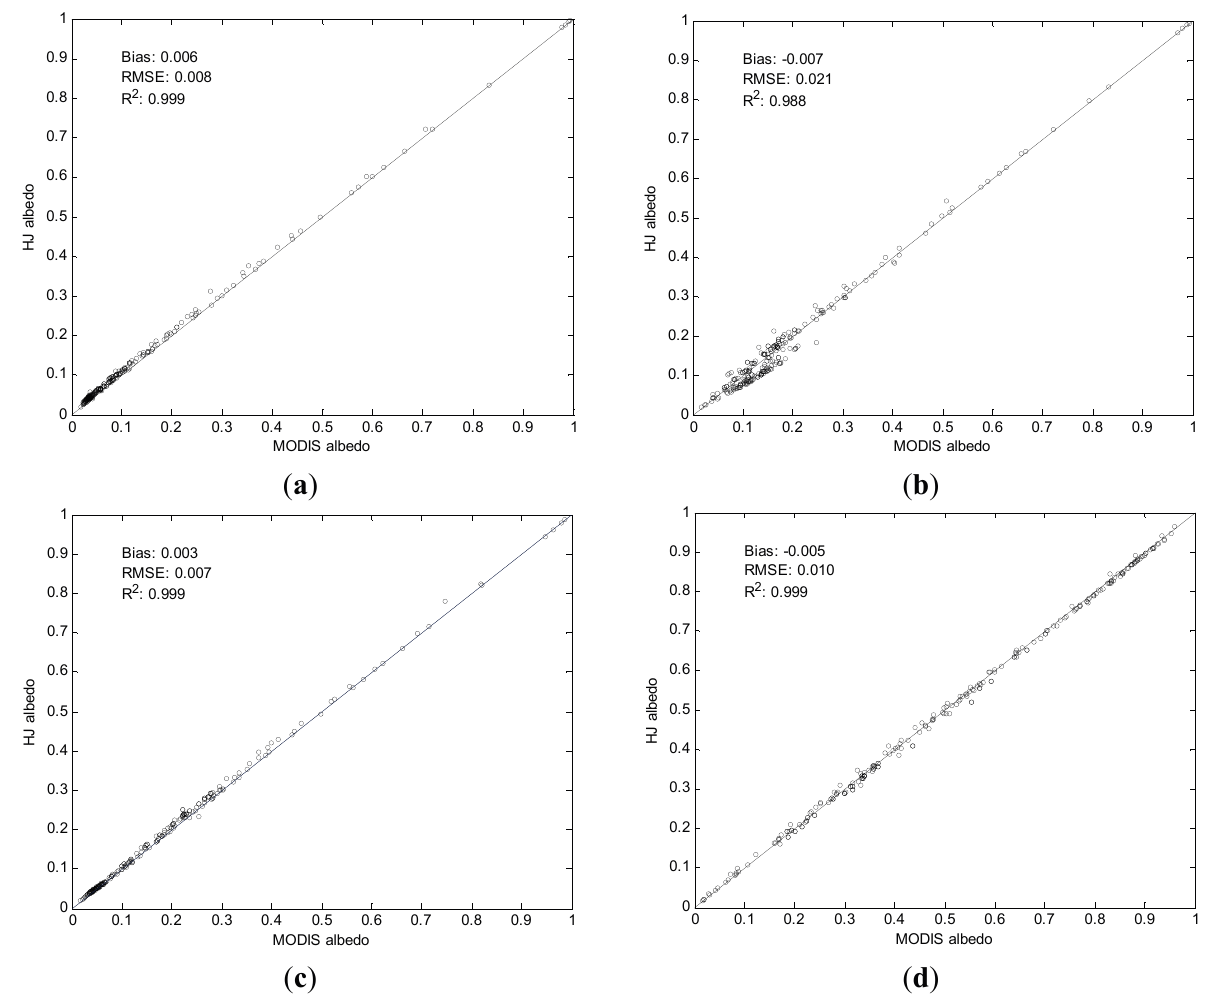
Figure 2. Comparison of spectral albedo integrated using surface albedo spectrum data and sensors’ spectral response functions: ( a ) HJ band 1 vs. MODIS band 3; ( b ) HJ band 2 vs. MODIS band 4; ( c ) HJ band 3 vs. MODIS band 1; and ( d ) HJ band 4 vs. MODIS band 2. All 245 spectrum samples are included in the scatter